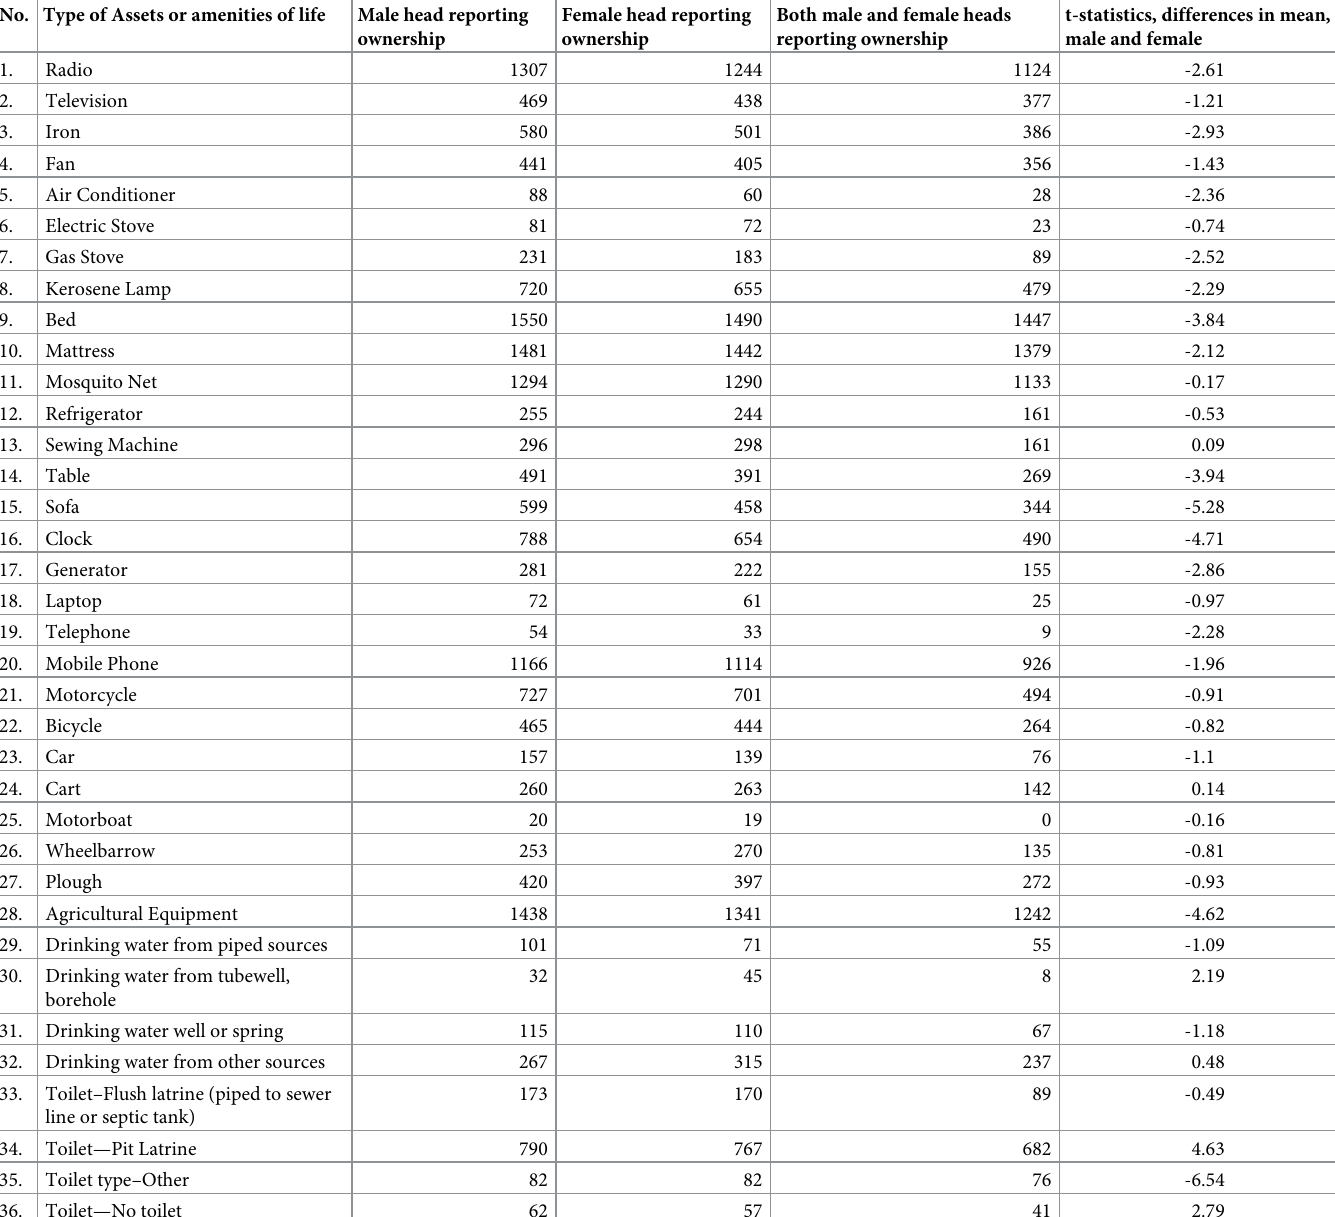
Table 2. Asset ownership as reported by male and female heads of households surveyed in northern Nigeria,